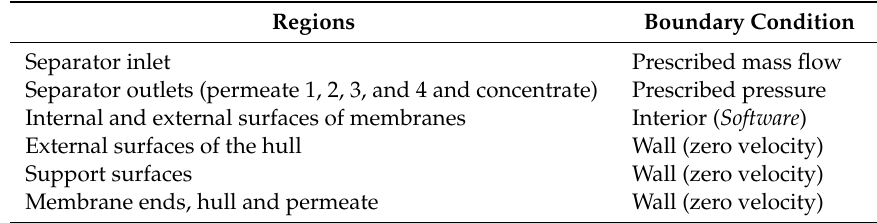
Table 4. Limit regions of the modules and boundary